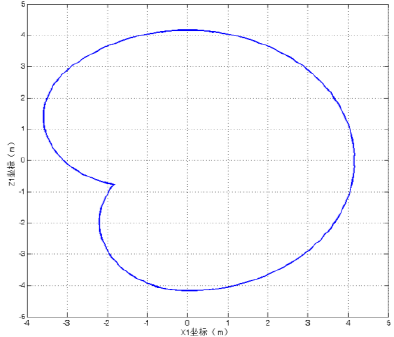
Figure 3. Structure sketch and connecting rod coordinate Figure 4. Reachable range in the operation plane system of arm Based on the known DH parameters of the manipulator and the condition of the body parameters, the three-dimensional workspace in the base coordinate system can be determined, as shown in Figure 5.